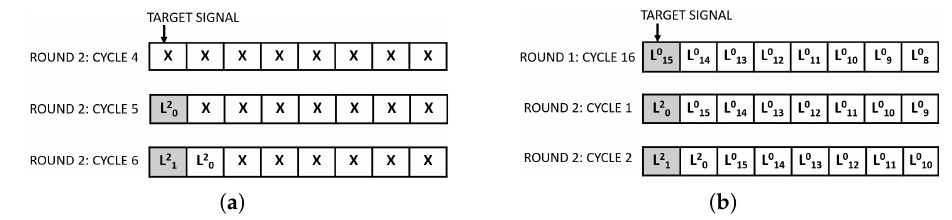
Figure 6. Contents of the 8-bit SRU loading the target signal at three cycles starting from ( a ) the fourth cycle of second round for the proposed adiabatic SIMON, ( b ) the last cycle of first round for the static CMOS based